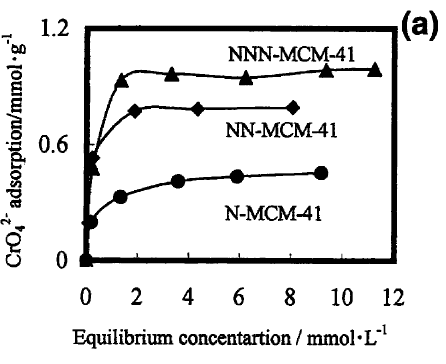
Figure 10. Adsorption isotherms of ( a ) arsenate and ( b ) chromate on mono-, di- and triamino-functionalized MCM–41 which are shown with N–MCM–41, NN–MCM–41 and NNN–MCM–41, respectively. Reprinted with permission from [169]. Copyright 2002 American Chemical